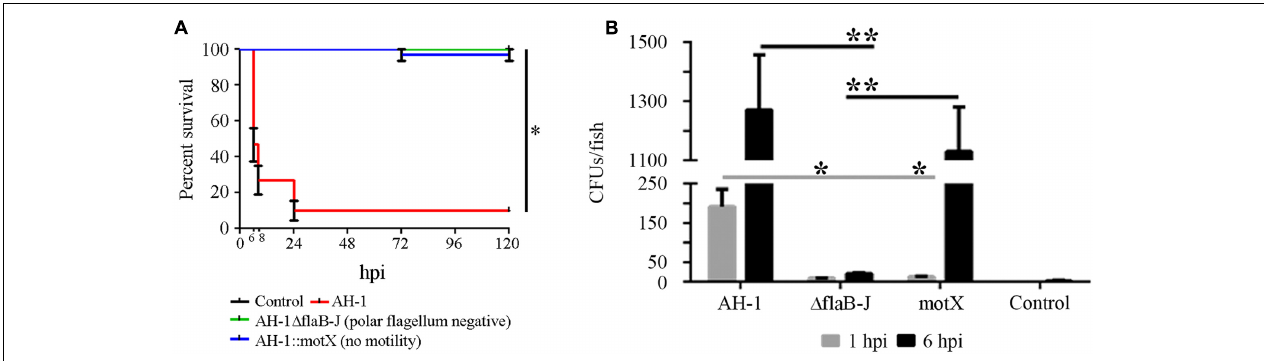
FIGURE 6 | Implication of the polar flagellum and the motility in the pathogenesis of A. hydrophila . (A) Kaplan–Meier survival curve of injured larvae infected with A. hydrophila AH-1 wild-type and the mutants AH-1 (cid:49) flaB-J (polar flagellum negative) and AH-1::motX (no motility). ∗ Significant differences at P < 0.0001. (B) Bacterial burden of infected larvae at 1 and 6 hpi. Mean ± SEM of two independent experiments are presented ( n = 10 larvae per group). ∗ p < 0.05, ∗∗ p < 0.01.